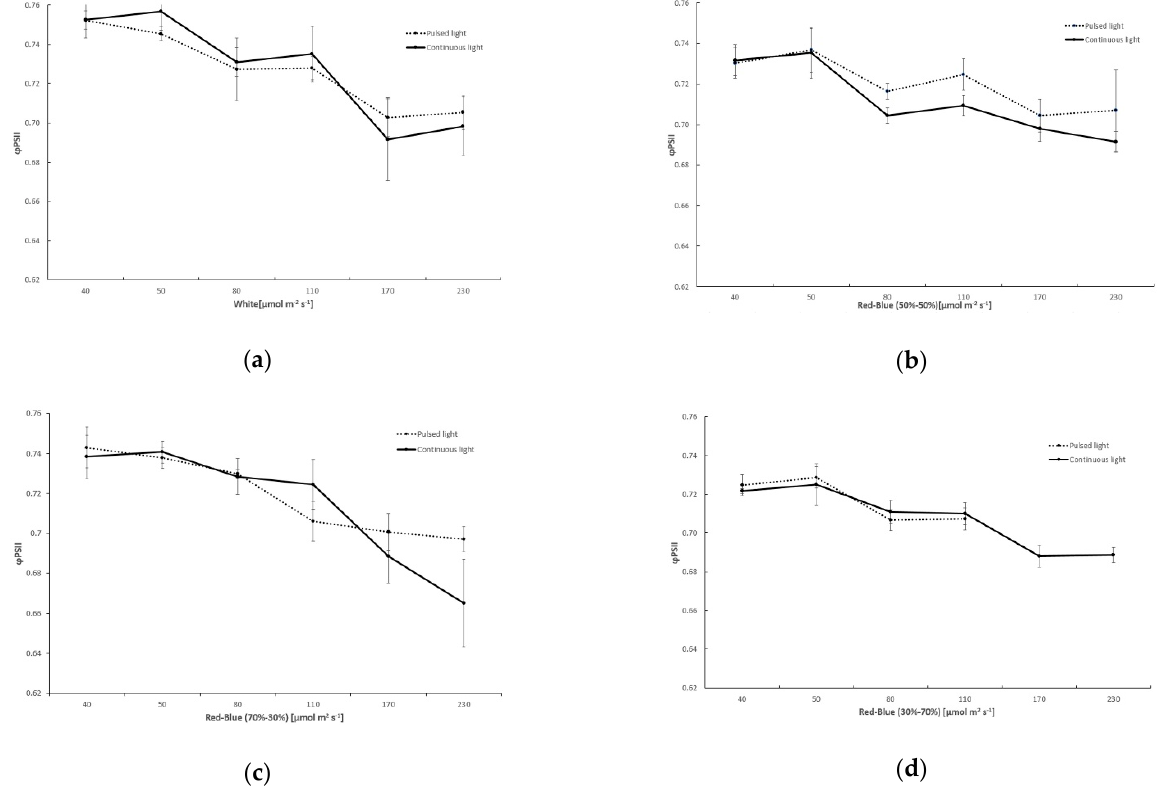
Figure 4. Results of the ϕ PSII in Pulsed mode versus continuous mode 60 min after the plant was treated. ( a ) White treatment. ( b ) Red − Blue (50–50%) treatment. ( c ) Red − Blue (70–30%) treatment. ( d ) Red − Blue (30–70%) treatment. All